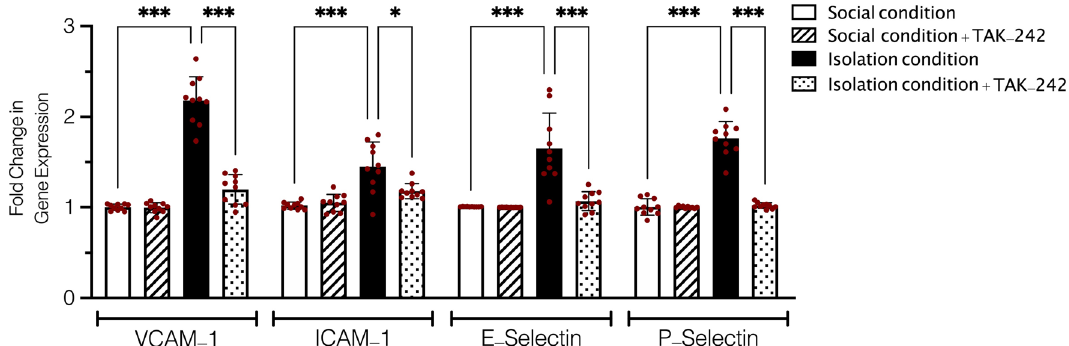
Figure 4. Fold change in gene expression of VCAM-1, ICAM-1, E-selectin, P-selectin receptors among SC, IC, and isolation conditioned animals treated with TAK-242 in aorta samples. Values are expressed as the mean ± S.E.M. (n = 10 in each group) results were analyzed using One-Way ANOVA followed by Tukey’s post hoc test. * P < 0.05 and *** P < 0.001 compared to social conditioned animals. # P < 0.05 and ### P < 0.001 compared to isolation conditioned animals.